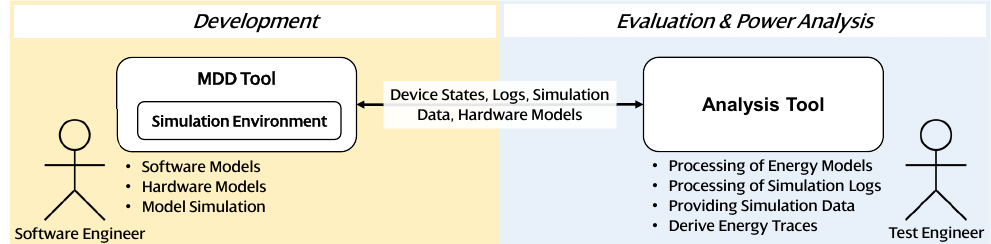
Figure 3. Indirect power analyses (IPA) concept to derive energy traces without a connected hard- ware